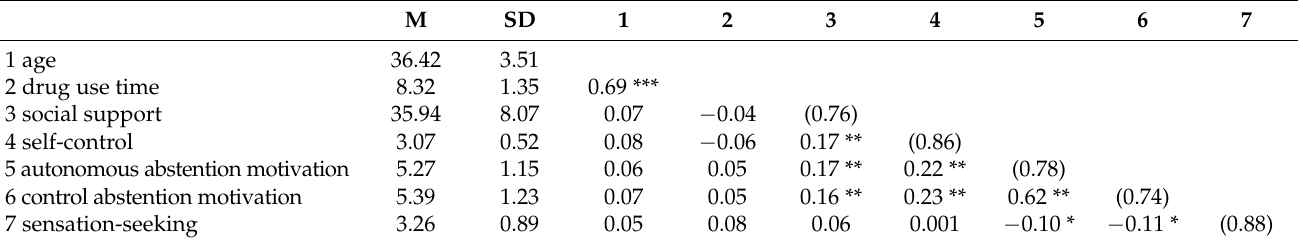
Table 1. Means, standard deviations, and Pearson correlation coefficients of main